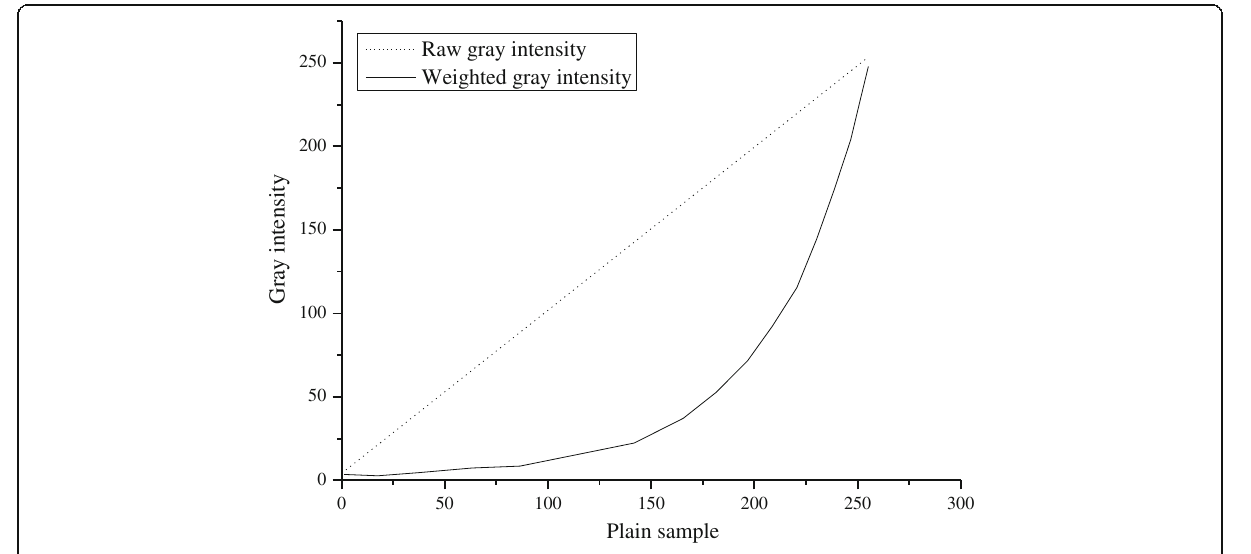
Fig. 3 The gray-weight transfer